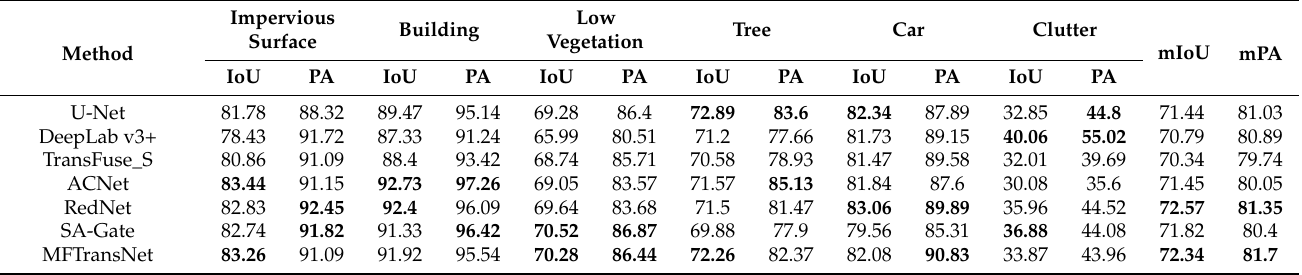
Table 3. Experiment results on Potsdam